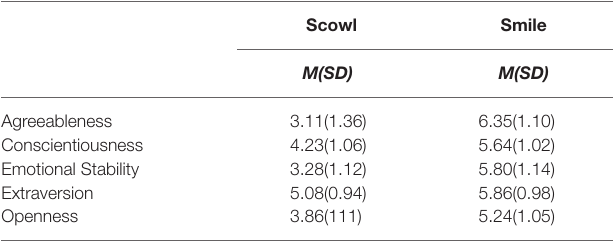
TABLE 1 | Overall comparison of mini-marker inferences made to smiling and scowling faces, M ( SD